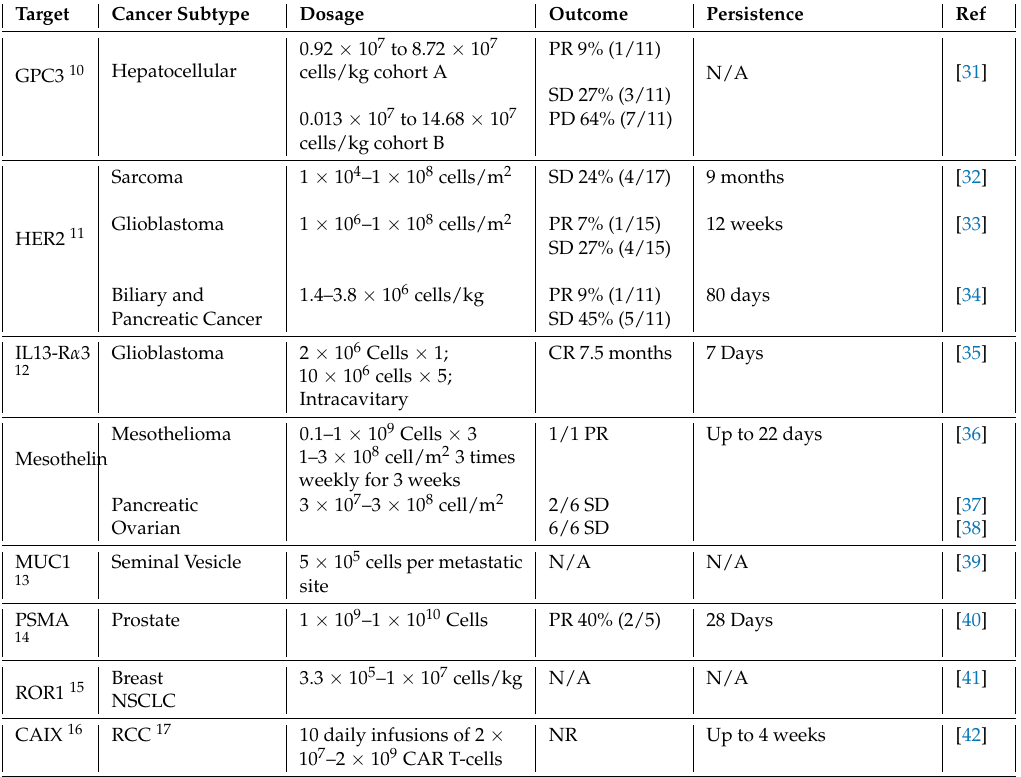
Disialoganglioside GD2. 10 Glypican-3. 11 Human Epidermal Growth Factor Receptor 2. 12 Interleukin-13 Receptor Alpha-2. 13 Mucin-1. 14 Prostate-specific membrane antigen. 15 Receptor Tyrosine Kinase Like Orphan Receptor